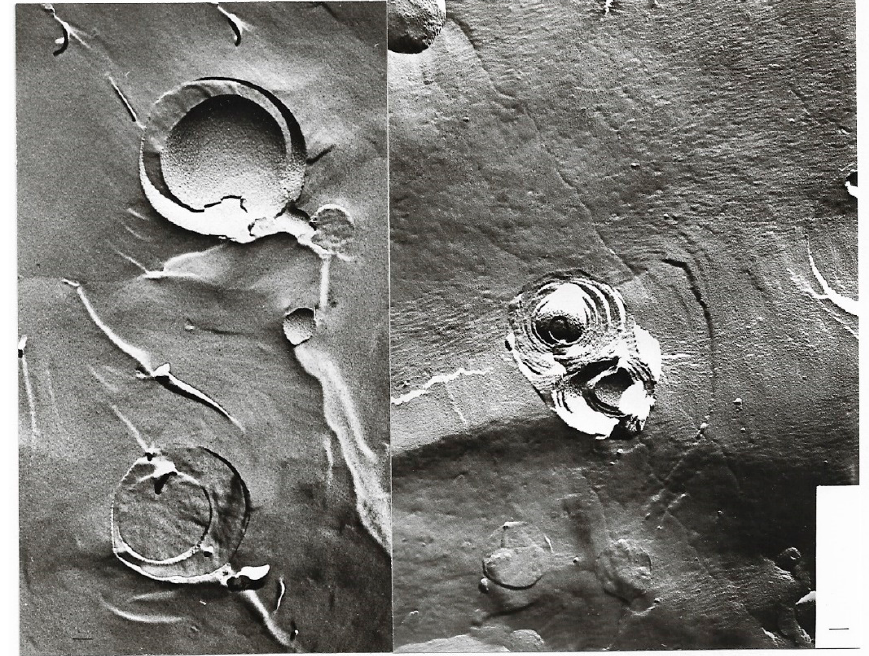
Figure 6. Freeze-fracture electron microscopy of mainly unilamellar liposomes after 5 ( a ) and 6 ( b ) Figure 7. Freeze-fracture electron microscopy of mainly unilamellar liposomes after 5 (a) and 6 (b) Int. J. Mol. Sci. 2019 , 20 , x FOR PEER REVIEW passages through the French pressure cell; magnification × 67,500; bar = 100 nm. passages through the French pressure cell; magnification ×67,500; bar = 100 nm.